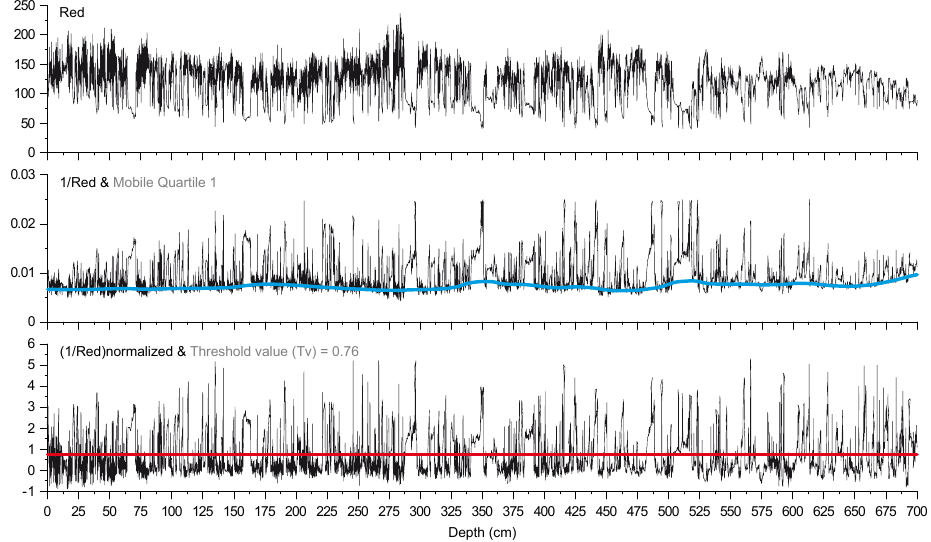
Fig. 4a. Raw and normalised red colour data from core LL08-1, and the threshold value detected with the Gaussian mixture model (Fig. 4b). (1/Red) normalised = (((1/red)-mobile quartile1)/Mobile standard-deviation); the running window is 1000 values.